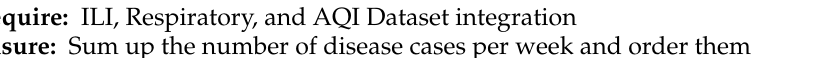
Algorithm 2 LSTM Training Methods